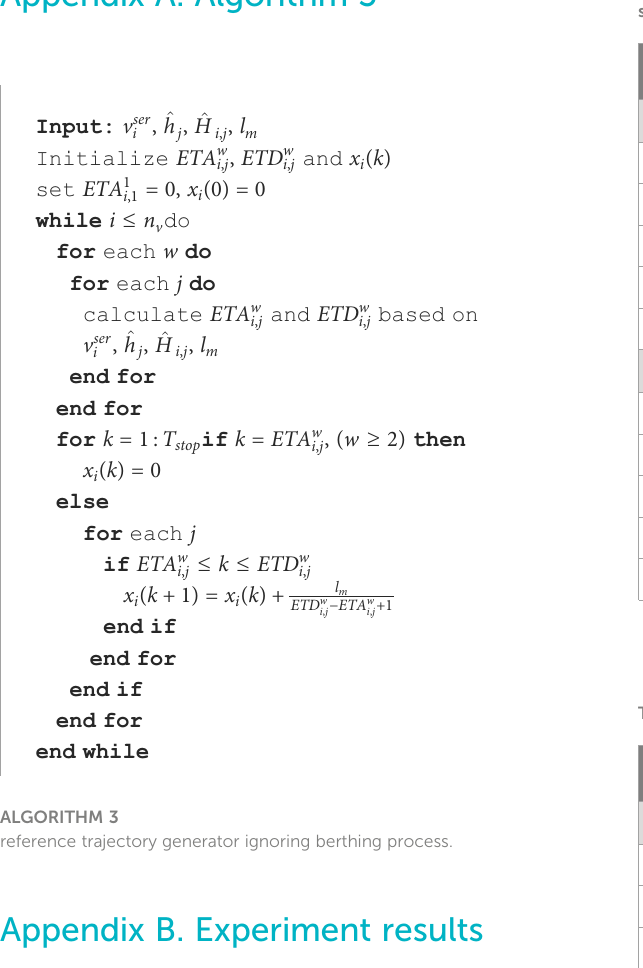
TABLE 9 ATA/ATD (Actual time of arrival/departure) in an uncontrolled scenario.